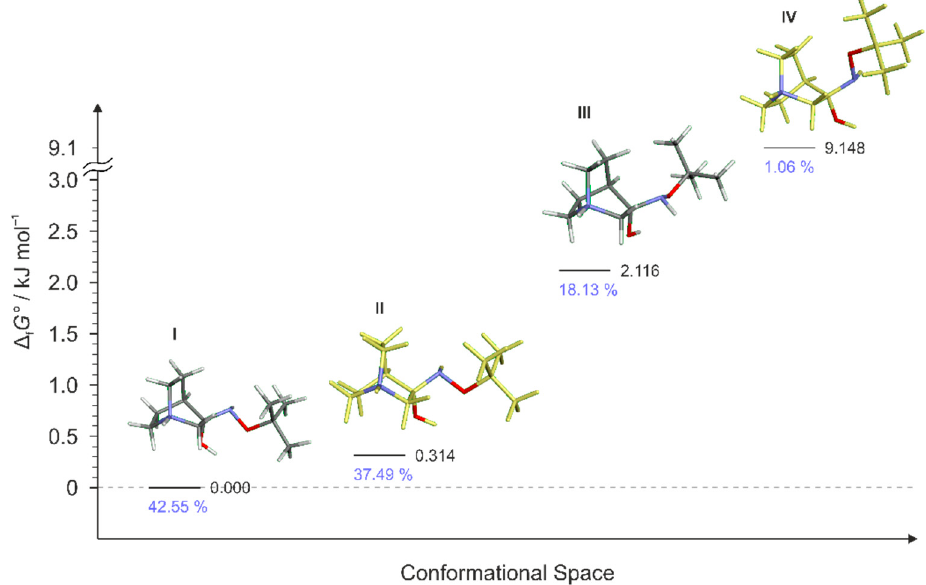
Figure 9. Four lowest energy conformers of RI2 and their relative standards Gibbs energies of formation Δ f G °calculated at the B3LYP-D3/6-311++G(d,p) level of the theory. (Relative fractions according to Boltzmann distribution at 298.15 K are given in blue.)